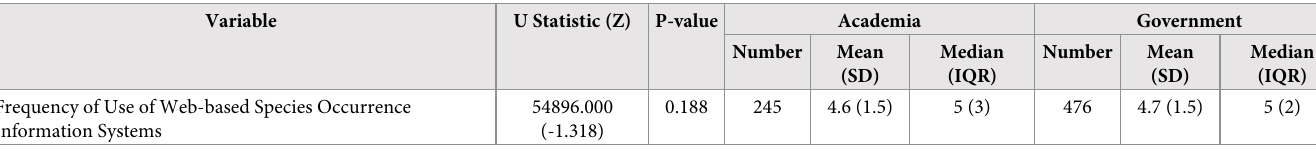
Table 11. Mann-Whitney U tests of frequency of use of web-based species occurrence information systems.